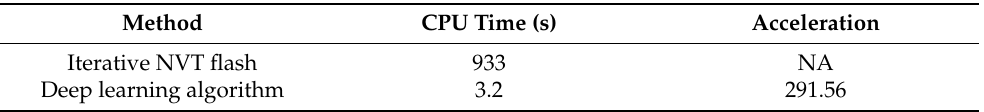
Table 1. Comparison between the CPU time used for iterative flash calculation and deep learning accelerated algorithm.